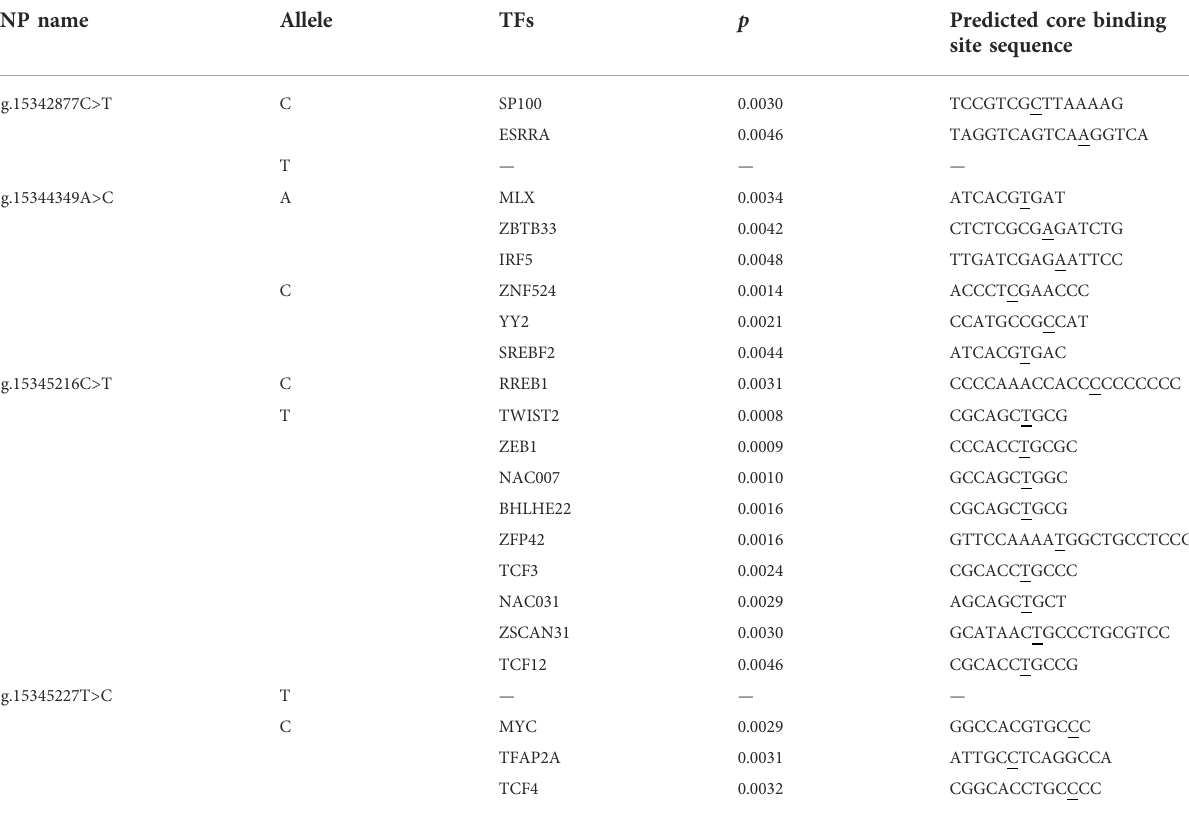
TABLE 3 Changes in transcription factors binding sites (TFBSs) caused by the SNPs in 5 9 regulatory region of PKLR .